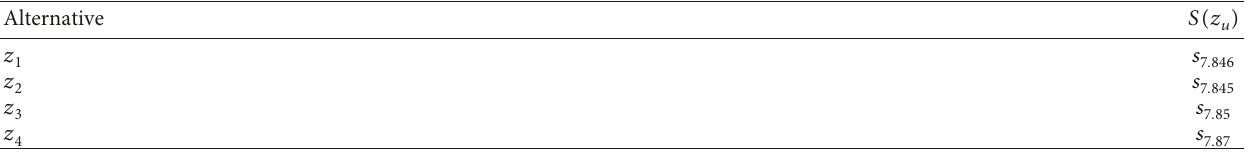
Table 17: Score function.